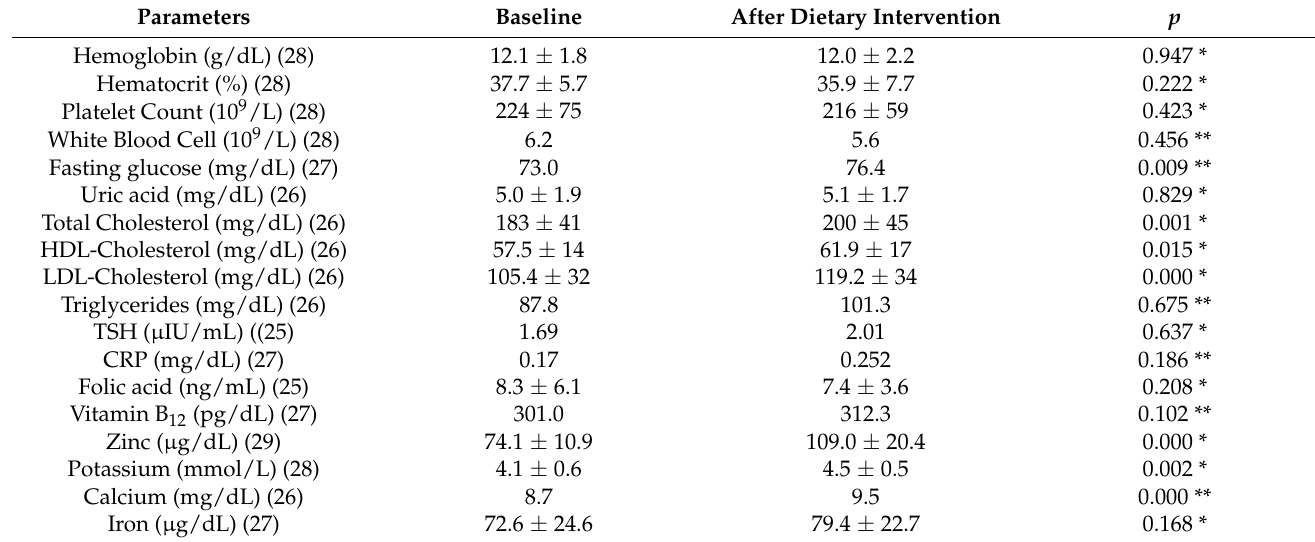
Table 6. Comparison of the hematological and clinical chemistry results before and after dietary intervention. Table 5. Changes in body mass and body composition among elderly individuals at baseline and after dietary intervention.